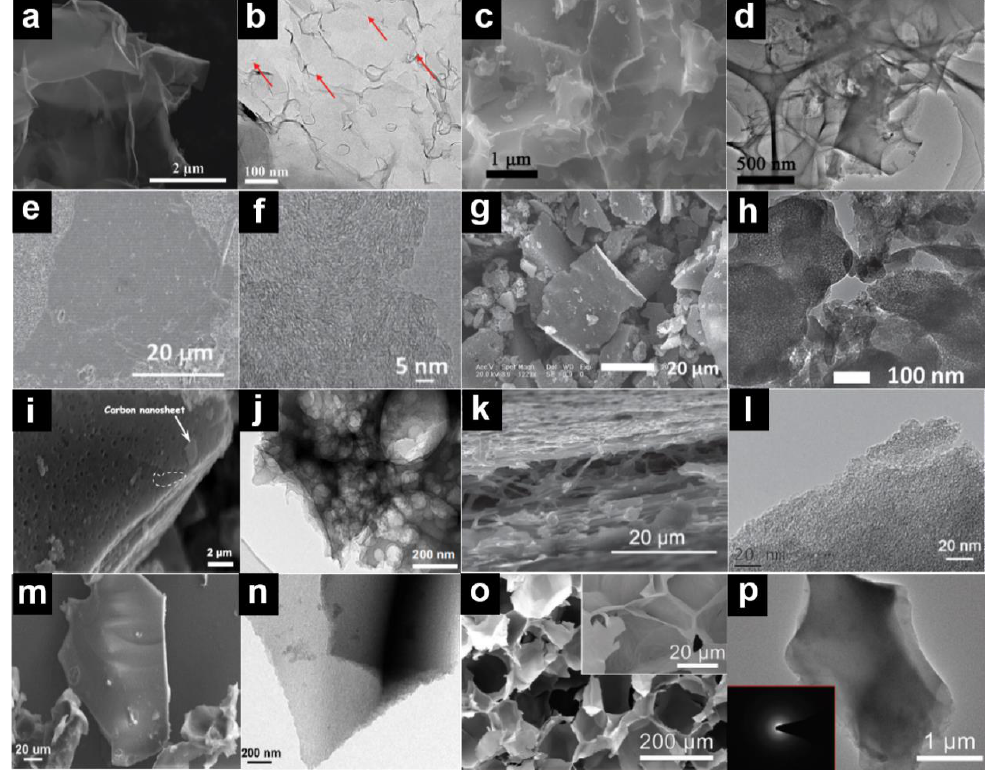
Figure 6. SEM and TEM images biomass-derived carbons produced from various precursors, including ( a , b ) highly graphitic carbon nanosheets from wheat stalk. Reproduced from [46], with permission from Royal Society of Chemistry, 2016; ( c , d ) N,S-doped porous carbon nanosheets from willow catkin. Reproduced from [29], with permission from Elsevier, 2016; ( e , f ) B/N co -doped carbon nanosheets from gelatin. Reproduced from [25], with permission from John Wiley and Sons, 2015; ( g , h ) heteroatom-doped carbon from microorganism (Bacillus subtilis). Reproduced from [36], with permission from John Wiley and Sons, 2012; ( i , j ) porous graphene-like carbon from fungus (Auricularis). Reproduced from [26], with permission from Elsevier, 2015; ( k , l ) carbonized eggshell membrane from chicken eggshell. Reproduced from [24], with permission from John Wiley and Sons, 2012; ( m , n ) hair-derived micro/mesoporous carbon from human hair. Reproduced from [18], with permission from Royal Society of Chemistry, 2014; ( o , p ) puffed rice derived carbon from rice. Reproduced from [41], with permission from John Wiley and Sons, 2017. Insets show the corresponding magnified SEM image and SAED pattern,